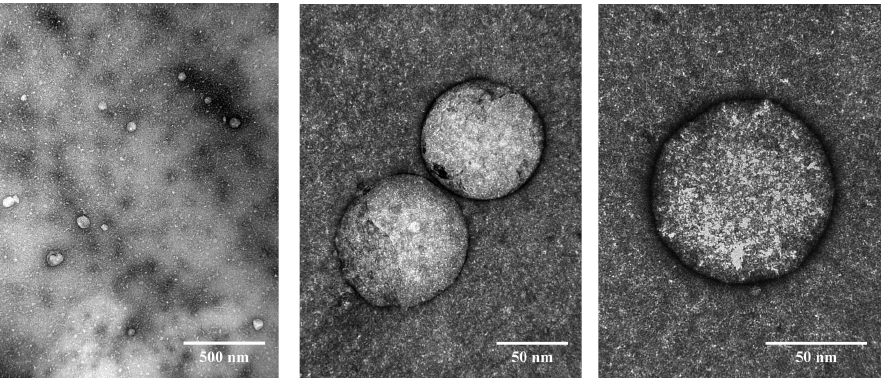
Figure 2 . TEM micrographs of g-C 3 N 4 -MA-COS nanocarriers loaded with R. tinctorum extract. Figure 2. TEM micrographs of g-C 3 N 4 -MA-COS nanocarriers loaded with R. tinctorum